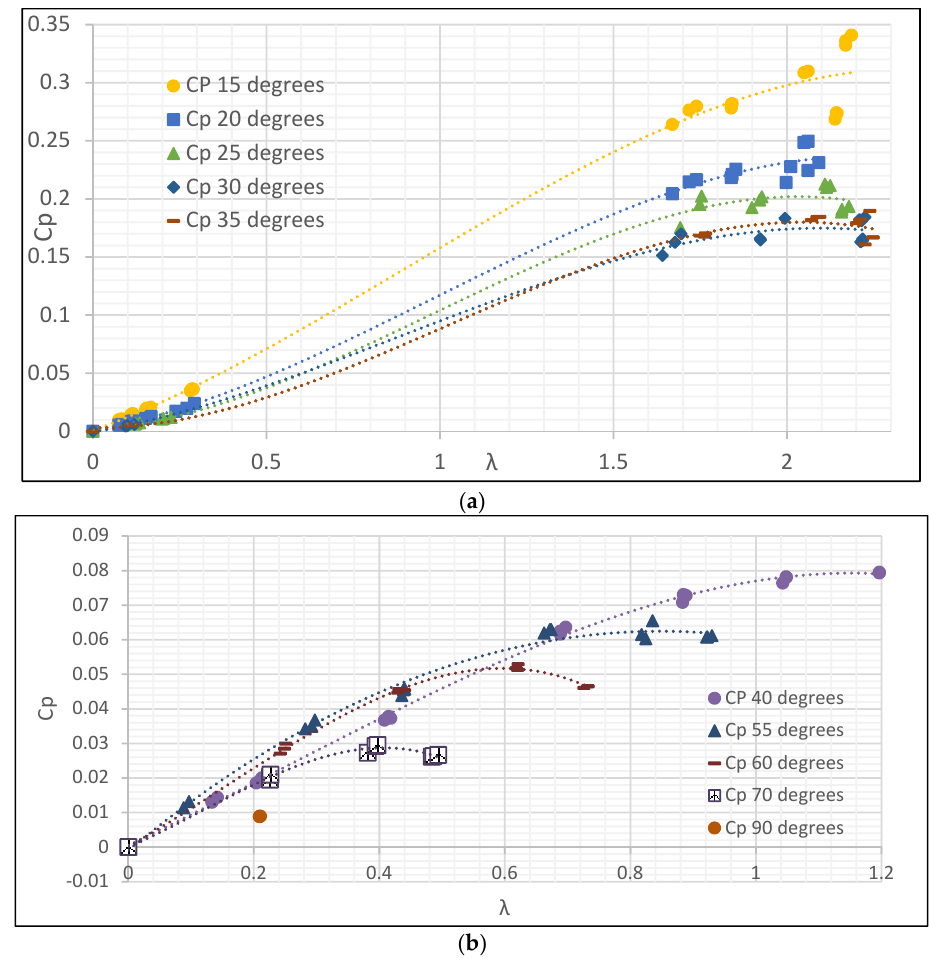
Figure 11. Cp Vs λ for different blade pitch angle. ( a ) from 15° to 35°. ( b ) from 40° to 90°. Machuguá wind rotor.